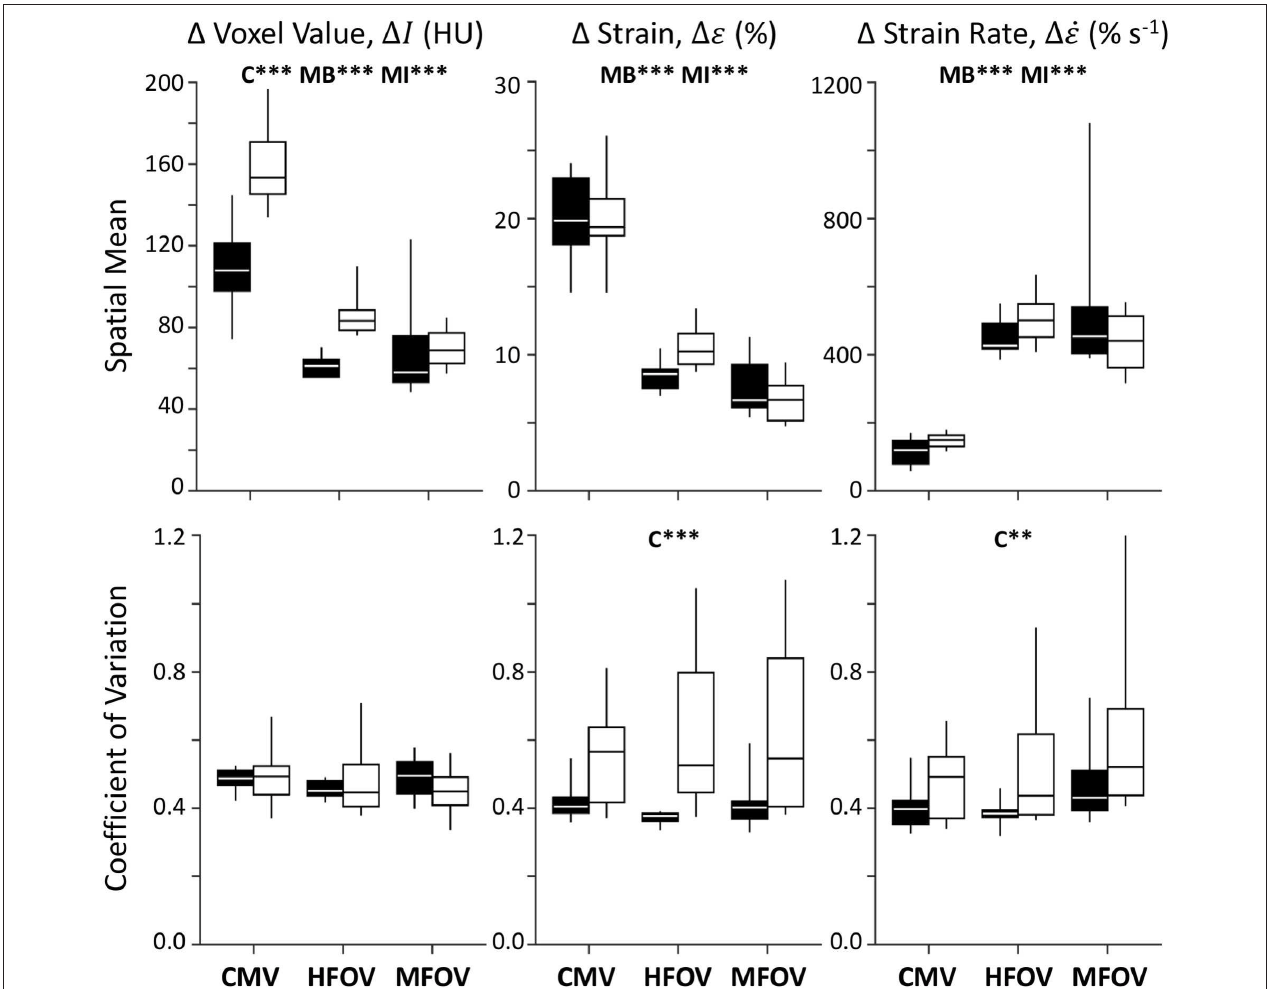
FIGURE 6 | Summary of image registration-based regional ventilation measures for intratidal changes in aeration ( 1 I ), volumetric strain ( 1ε ), and volumetric strain rate ε ). Mean and coefficient of variation throughout the lung mask are shown for each variable, represented by box plots showing minimum, maximum, and quartiles ( 1 ˙ across subjects under baseline (black) and injured (white) conditions, during conventional mechanical ventilation (CMV), high-frequency oscillatory ventilation (HFOV), and multi-frequency oscillatory ventilation (MFOV). Asterisks indicate significance levels (** p < 0.01, *** p < 0.001) for main effects (C for baseline condition, MI modality for injured condition). See Table 2 for additional =